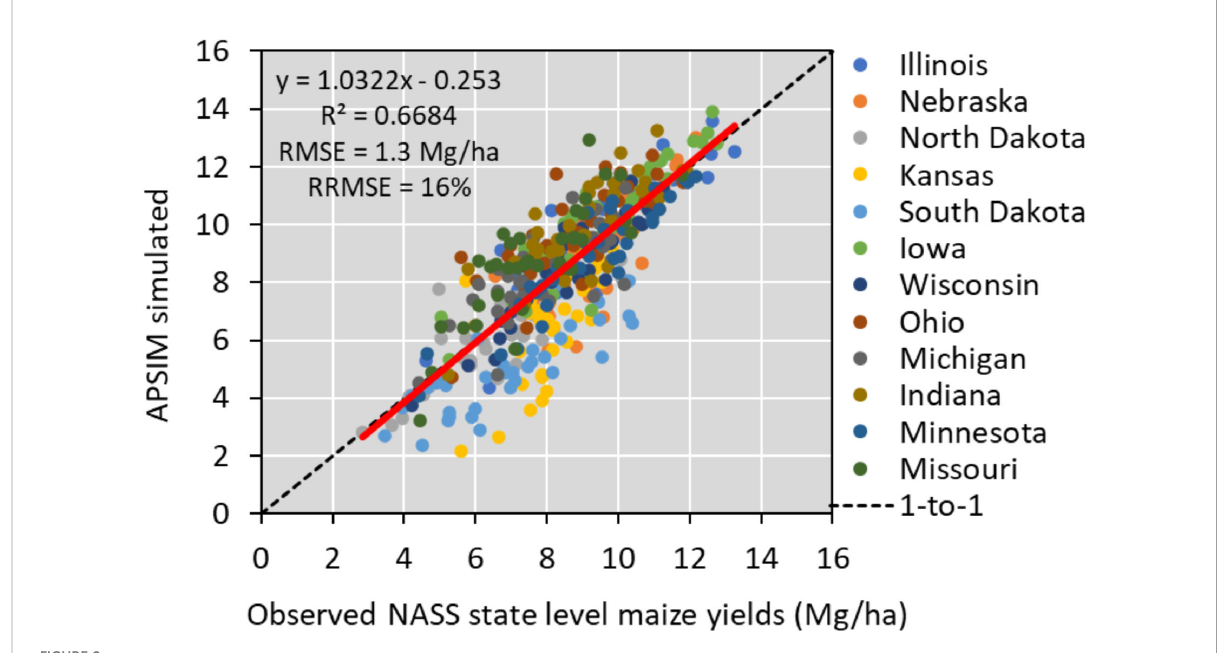
FIGURE 2 APSIM model performance in simulating historical yields in the US Corn Belt. The red line represents the relation between the predicted and observed yield for each state and has a R 2 value of around